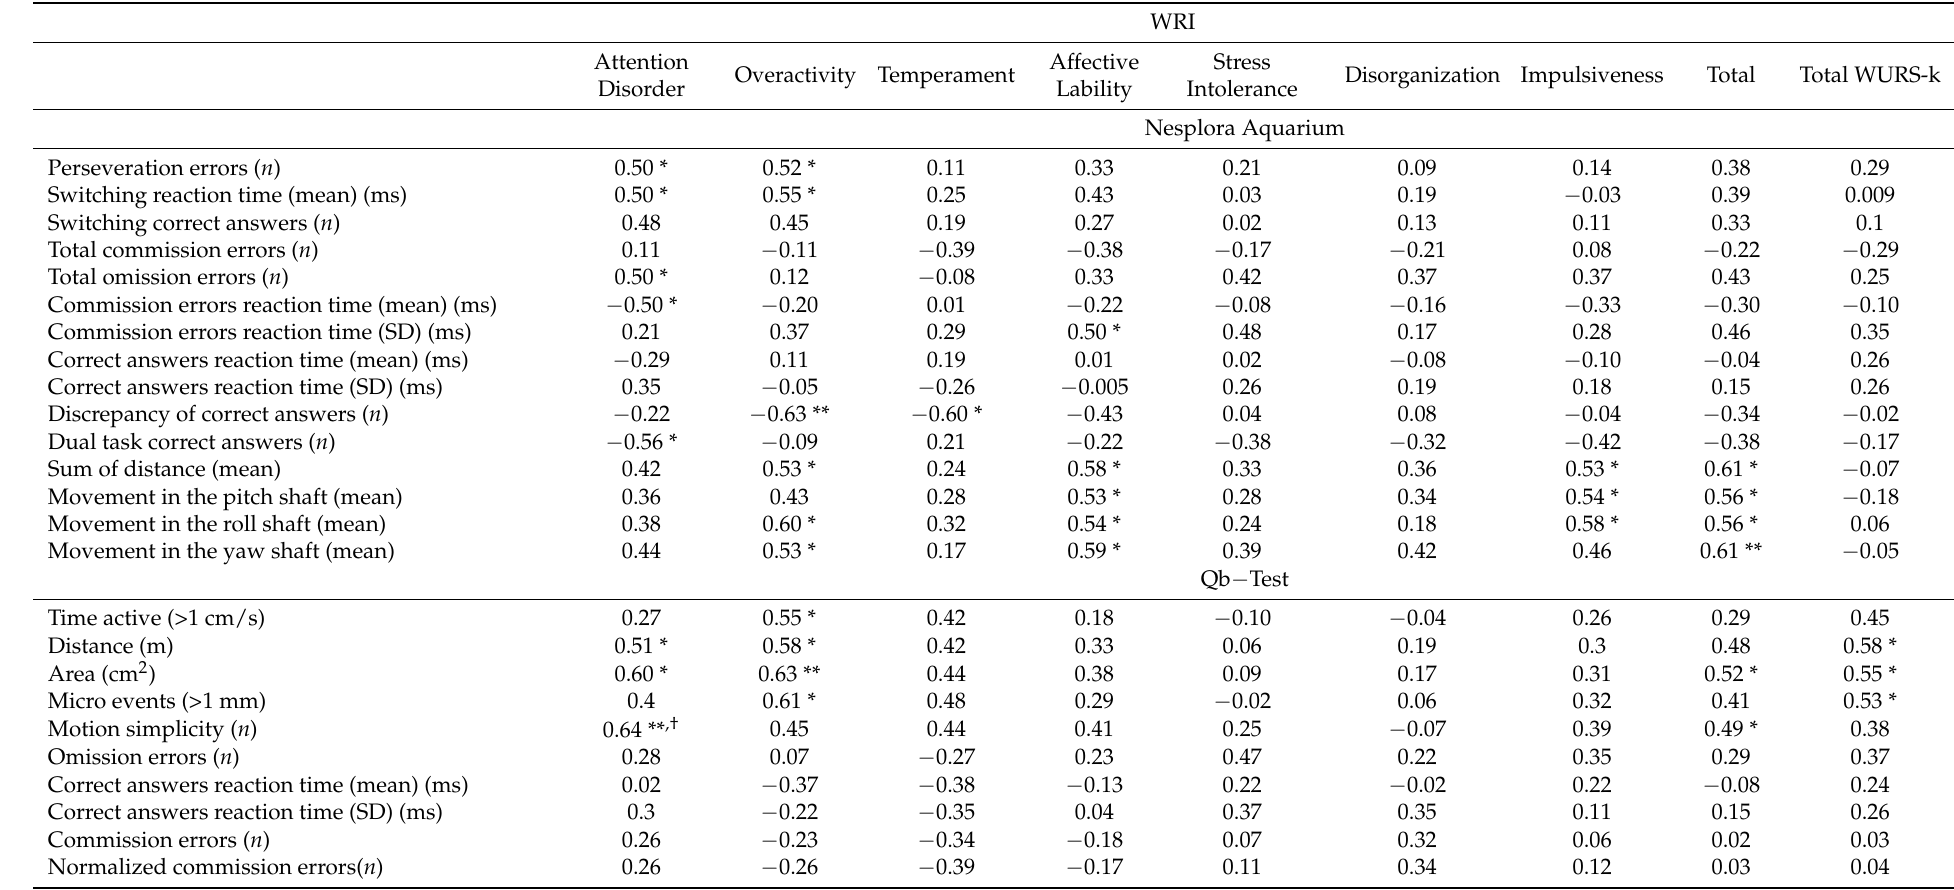
Table 6. Correlations of the underlying variables of the principal components of Nesplora Aquarium and the Qb-Test with WRI, WURS-k, UPPS, and GHQ-28.